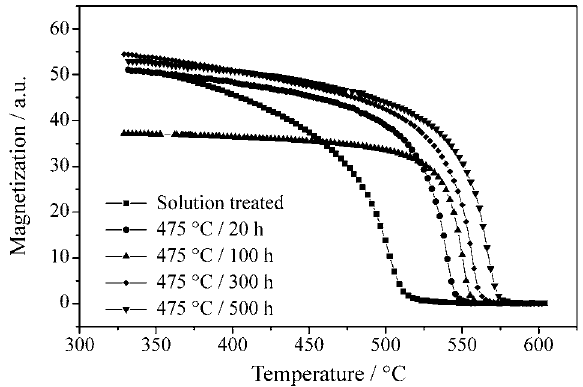
Figure 4. TMA comparative curves at increasing temperatures. Figure 6. T c dependence on the time of exposure at 475 °C.